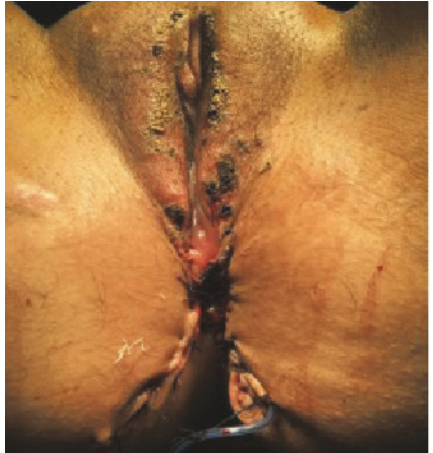
Figure 6: The appearance of Case 2 immediately after surgical